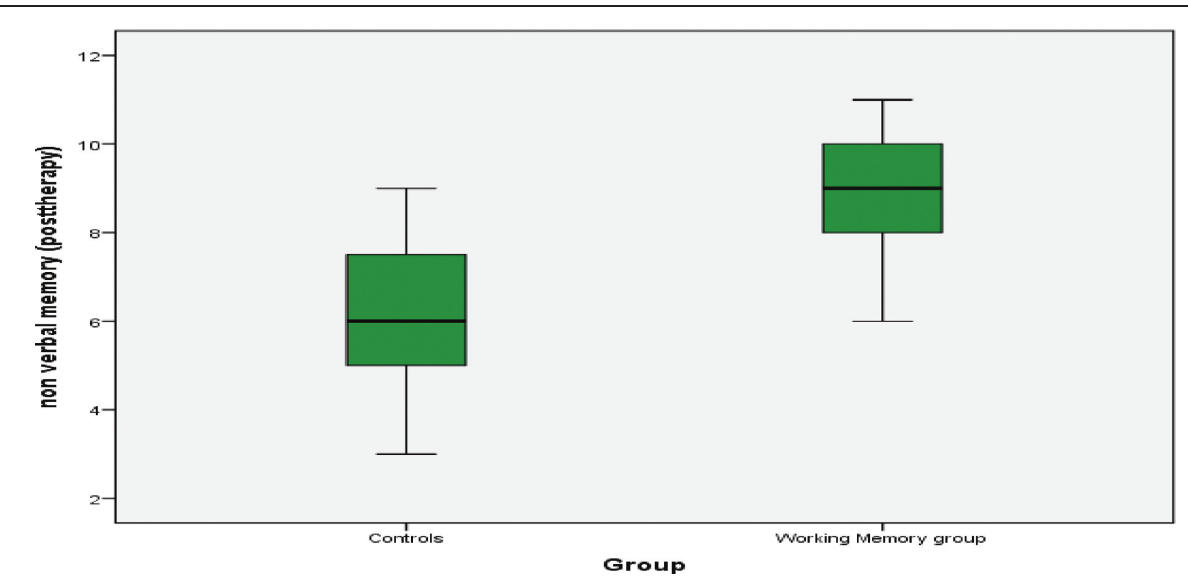
Comparison between two groups in nonverbal memory post-therapy results.